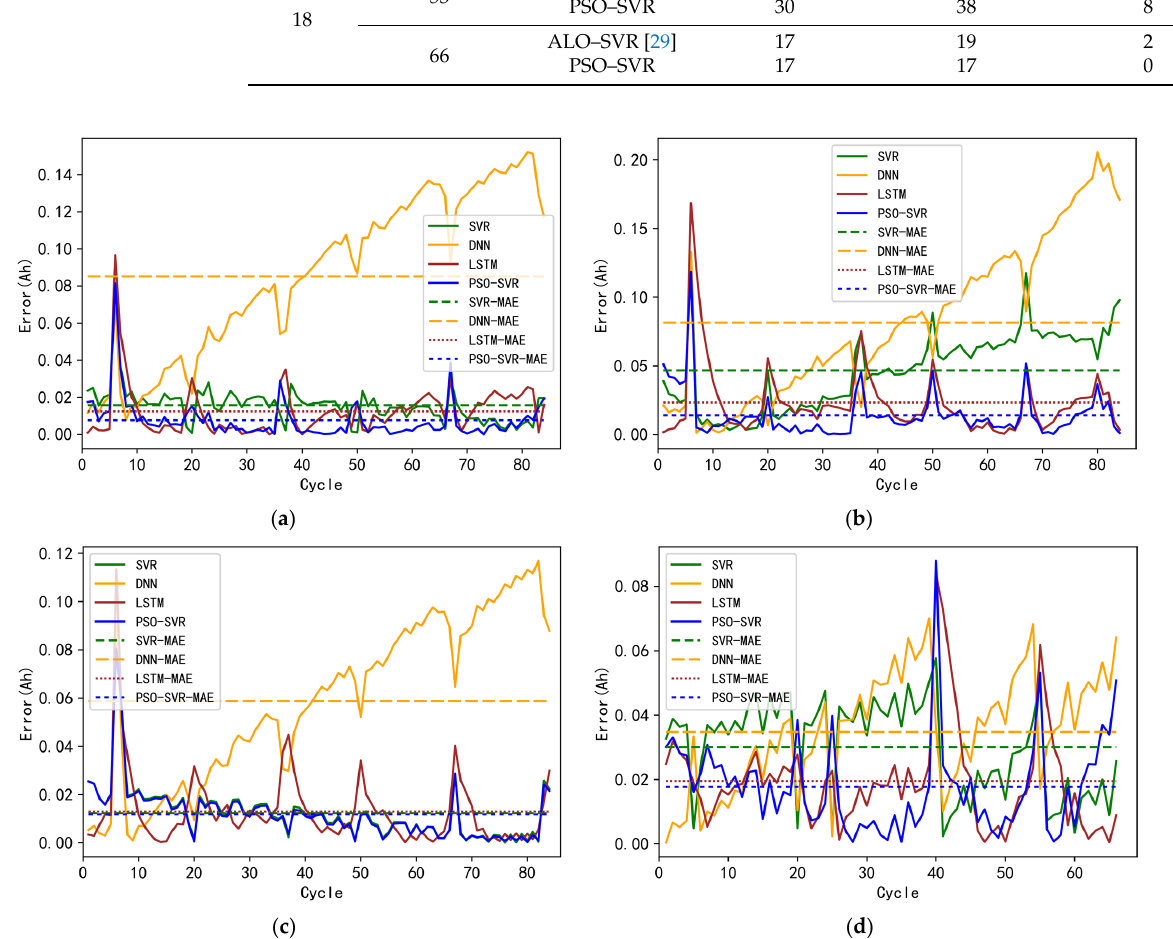
Figure 8. Absolute error and mean absolute error based on SVR, DNN, LSTM and PSO–SVR using the first 40% of the total cycle data for training: ( a ) B5; ( b ) B6; ( c ) B7; ( d ) B18.